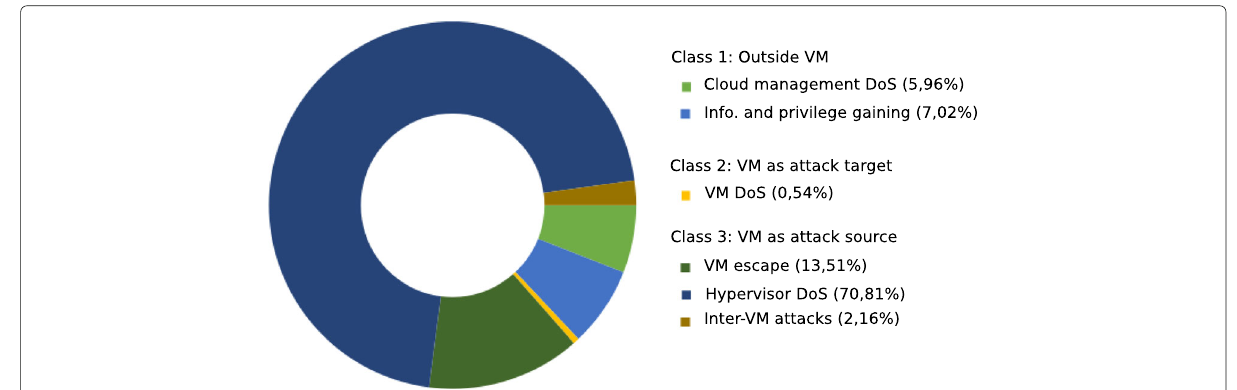
Fig. 2 CVE entries for the three classes of